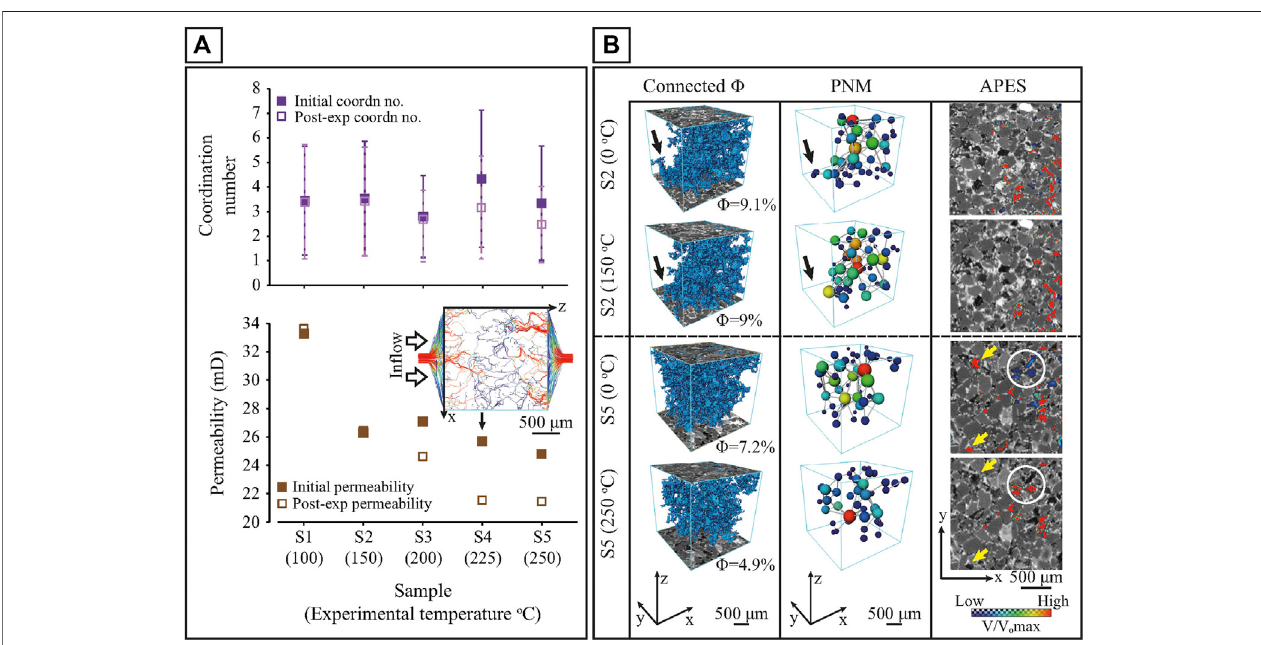
FIGURE 4 | PNM and APES of the cubic subvolumes of samples S1-S5. (A) Evolution of the mean coordination number (number of contacts a pore has with its neighbors) and permeability per sample and experimental temperature, derived from the pore network modeling and permeability simulations, respectively. Error bars correspond to the standard deviation. Included is aschematic diagram ofthe permeability simulation along the z -axis of sample S4 prior to hydrothermal treatment. The model is color-coded with slower streams being near the blue end of the spectrum, and faster streams near the red end of the spectrum. (B) 3D renders of the connected porosity (left), pore network models (middle) and fl uid velocity magnitude maps (right) of samples S2 and S5 before and after the hydrothermal experiments. Theporespaceoftheporenetworkmodelsisrepresented asalatticeofwidepores(shownasspheres)connectedbynarrowerthroats(shownascylinders).Thesizeof theporeandthroatindicatestheinscribedradiusandlength,respectively.Redindicatesvolumetricallylargerporesandblueindicatesporeswithsmallerradius.The fl uid velocitymaps arenormalized tothe maximum velocity value ofeach sampleasderived fromthepermeability simulation priortotheexperiment. Notethat slight changes betweenthepre- and post-reaction connectedporositynetworkofsampleS2(black arrows) donotaffectthe fl owpathways. Signi fi cantalterations occurat 250 ° Cwith extinctionofpre-reactionpreferentialpathways(yellowarrows)and fl owenhancementofinitiallylow fl uid fl owvelocityregions(circled).Forinterpretationofthereferences to color in this fi gure legend, the reader is referred to the web version of this